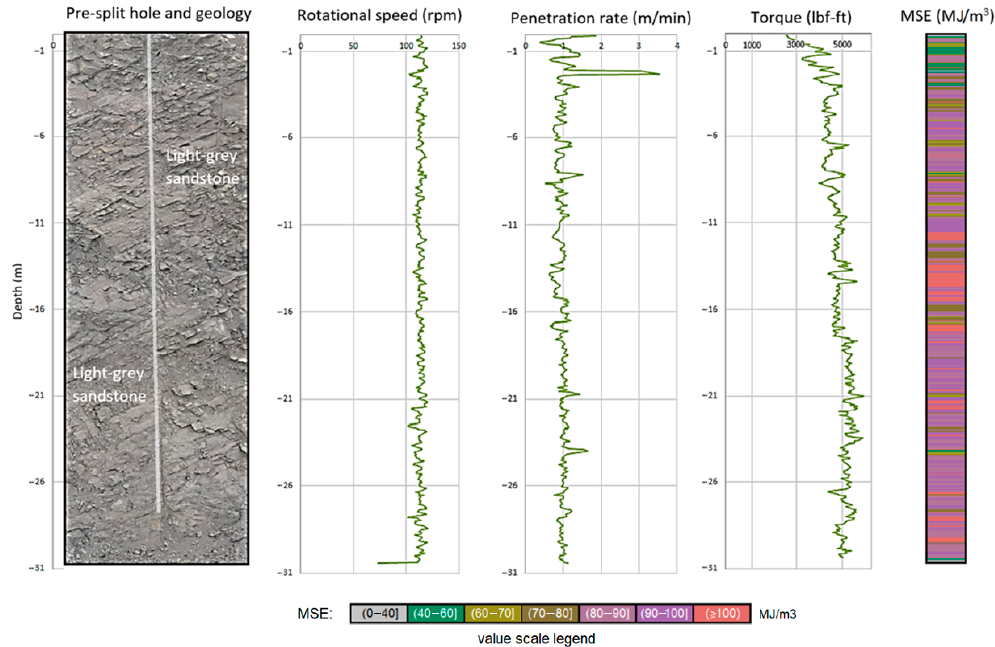
Figure 12. A dependence plot of MWD data on borehole depth for the borehole No. 469 in block No. K 67–78.